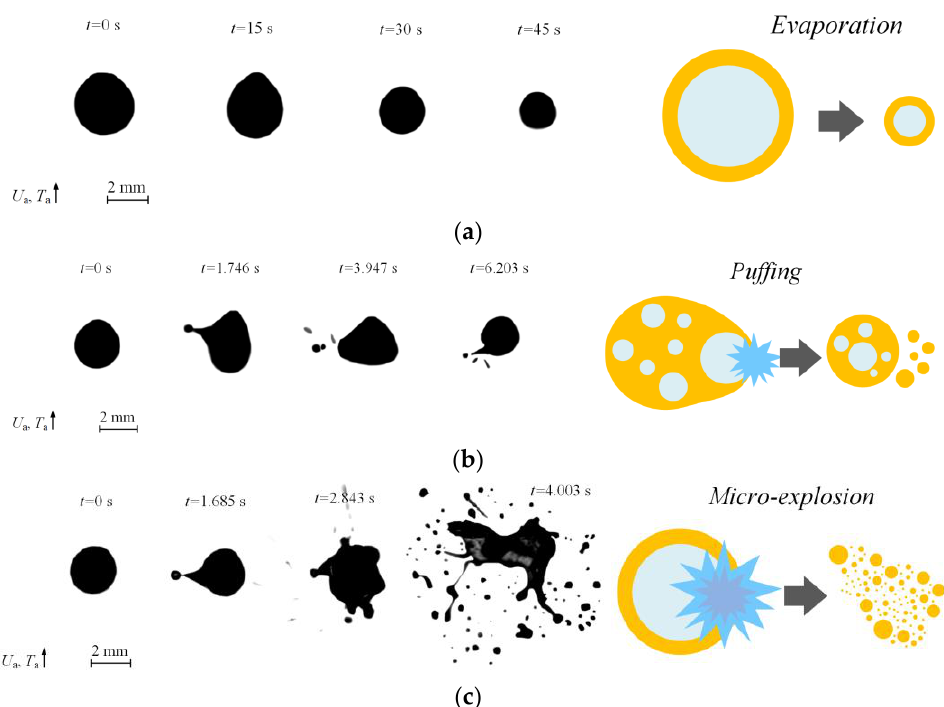
Figure 2. Typical images and schemes of fuel emulsion droplet heating, expansion, evaporation, puffing, and micro-explosion regimes ( U a = 3 ± 0.1 m/s, R d0 = 1.2 ± 0.1 mm, η f = 90 ± 5%) obtained using the method described in Ref. [116]: ( a ) — evaporation without fragmentation ( T a = 473 ± 5 K), ( b ) — puffing ( T a = 573 ± 5 K), ( c ) — micro-explosion ( T a = 673 ± 5 K). Figure 3 highlights the temperature ranges in which different modes of two-liquid droplet heating, evaporation, puffing, and micro-explosion occurred. The transient areas are shaded where two outcomes were observed with different repeatability.